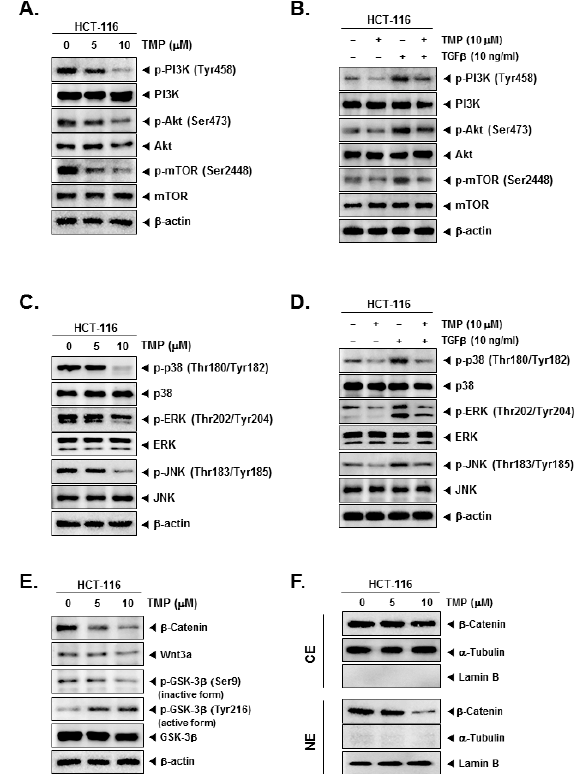
Figure 3. Effect of TMP on TGF β -induced PI3K/Akt/mTOR, MAPK, and Wnt/ β -catenin pathways activation in HCT-116 cells. ( A , C , E ) HCT-116 cells were seeded and treated with TMP (0, 5, 10 μ M) for 6 h. The cell lysate was prepared with an equal amount of proteins. The expression of indicated proteins was examined by Western blot analysis. ( B , D ) HCT-116 cells were seeded and treated with TMP (0, 5, 10 μ M) for 3 h, and TGF β (10 ng/mL) for 3 h. The cell lysate was prepared and subjected to Western blot analysis to analyze the expression of indicated proteins. ( F ) Cytoplasm extracts (CE) and nucleus extracts (NE) were extracted from TMP (0, 5, 10 μ M, 6 h)-treated HCT-cells. β -catenin, α -Tublin, and Lamin B was probed and examined by Western blot analysis. Each experiment was repeated at least thrice independently.